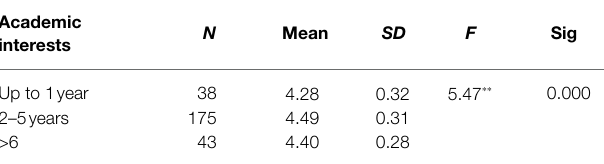
TABLE 7 | ANOVA by teaching experience of teachers.